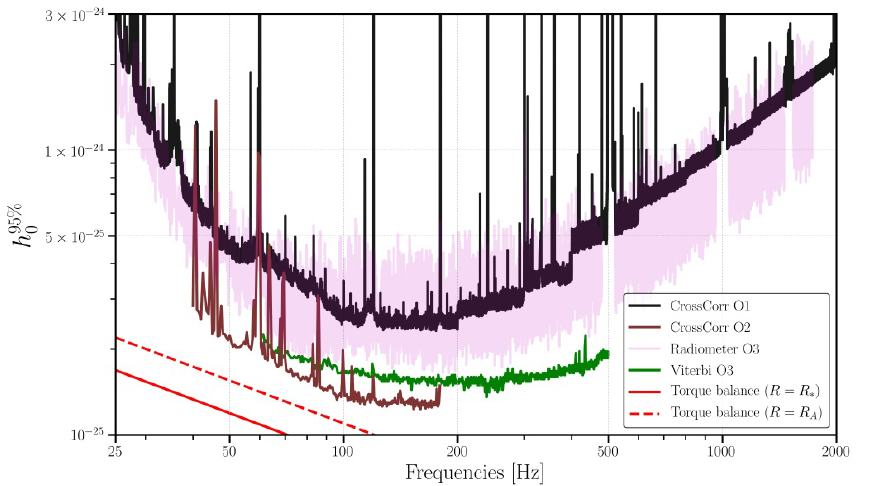
Figure 4. GW strain upper limits at 95% confidence as a function of frequency. No assumption on the ι angle is made for the curves in the figure. The curves are for the CrossCorr O1 search [262] (black line), the CrossCorr O2 search [259] (brown line), the Radiometer O3 search [269] (light pink line), and the O3 hidden Markov model search [263] (green line). The indirect torque-balance upper limits (see Equation (13)), for the r m = R case (red solid line) and for r m equal to the Alfven radius (dashed red line), are also plotted. Figure taken from